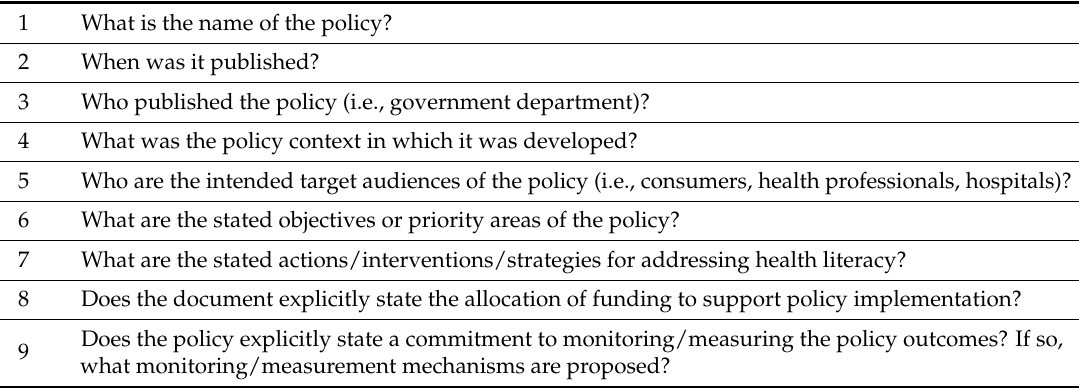
Table 1. Criteria for analyzing and extracting data from policy